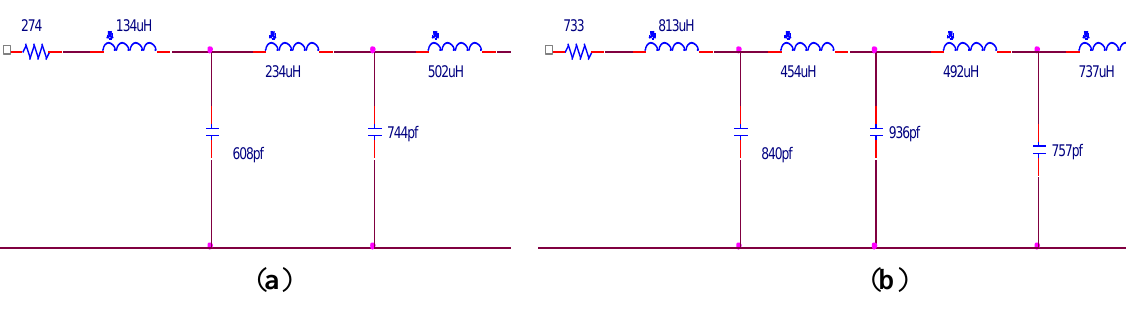
Figure 13. Topologies with five and seven branches: ( a ) five ( b )